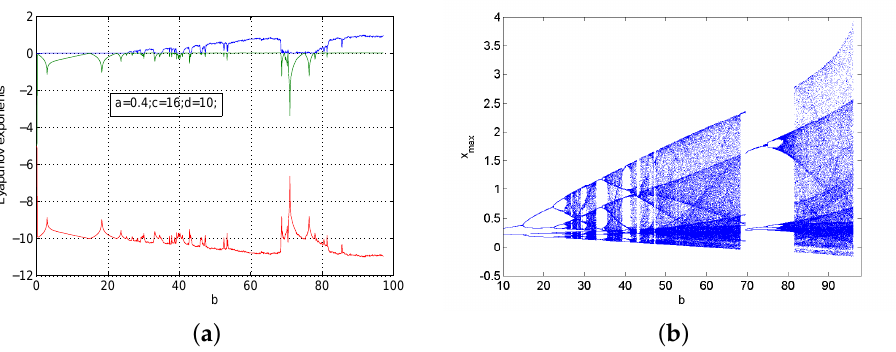
Figure 4. The Lyapunov exponents spectrum and the bifurcation diagram of system (1) with ( a , c , d ) = ( 0.4,16,10 ) and 0 < b < 97 at the initial values ( 0.01,0.01,0.01 ) T : ( a ) Lyapunov exponents; ( b ) bifurcation diagram.